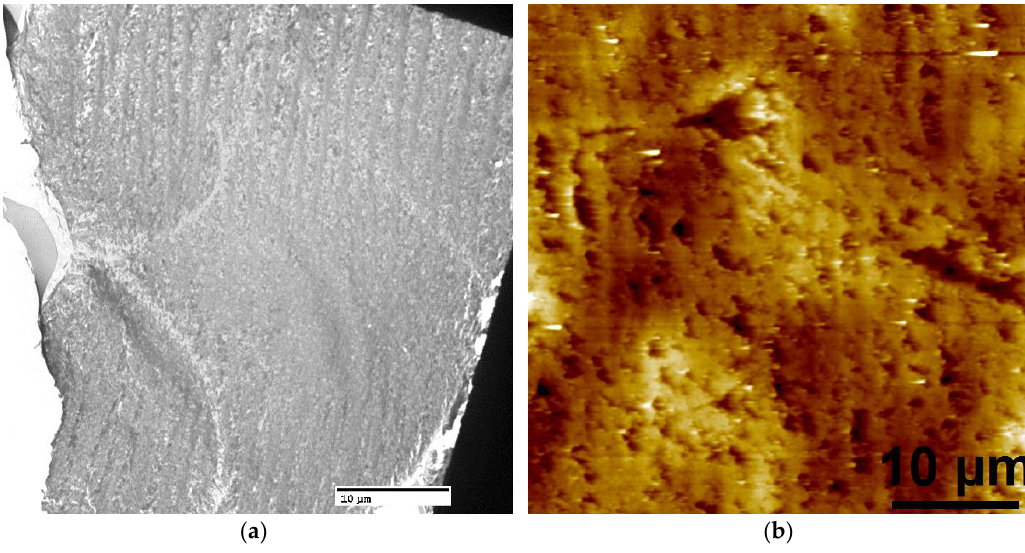
Figure 3. Bright field TEM (BF-TEM) and AFM height image of mineralized LCC cholesteric microstructure and “domain” boundaries. ( a ) The non-crosslinked control, X0, had cholesteric domains that spanned 10’s of microns and appeared to have a globular three-dimensional shape, as judging from circular domains in the two-dimensional image; and, ( b ) Similar features were identified via AFM. Despite being highly mineralized, these structures closely resemble the schematic description of interconnected cholesteric collagen spherulites and isotropic defects that have been observed, and schematically depicted, by Mosser and colleagues [39].